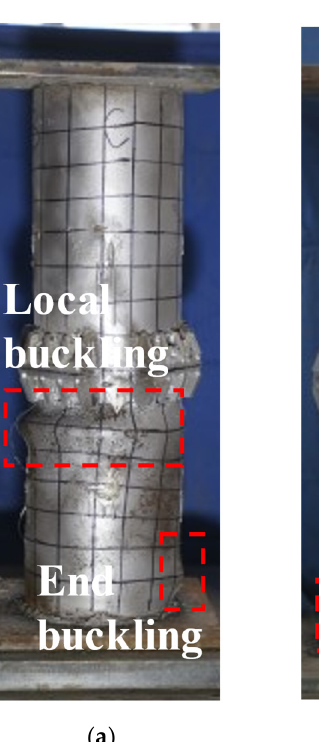
( b ) Figure 8. N - Δ curves of BWCFST specimens with different initial imperfections: ( a ) BWCFST with interfacial gap; ( b ) BWCFST with spherical-cap gap.